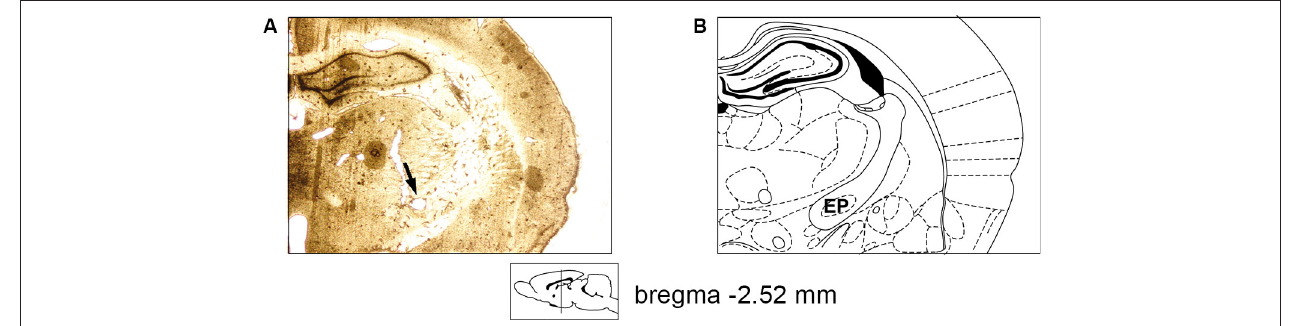
during 5 s (left) and spike train during 20 s (right). (C) Autocorrelation using a time window of ± 1 s (left) and autocorrelation with x -axis expanded to 0.1 s (right) of the same neuron. (D–H) Waveform and firing parameter histograms.